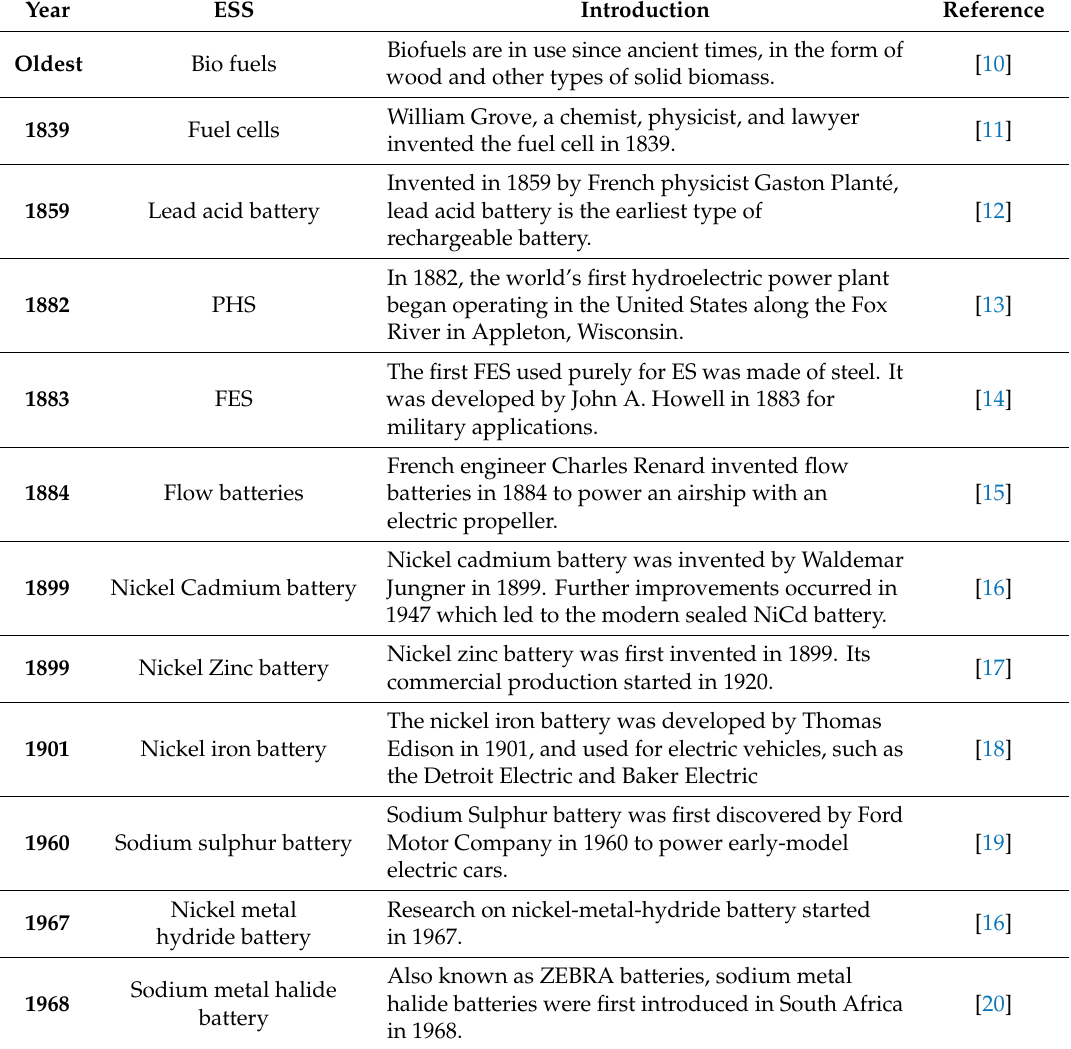
Table 1. The evolution of energy storage systems (ESSs) in chronological